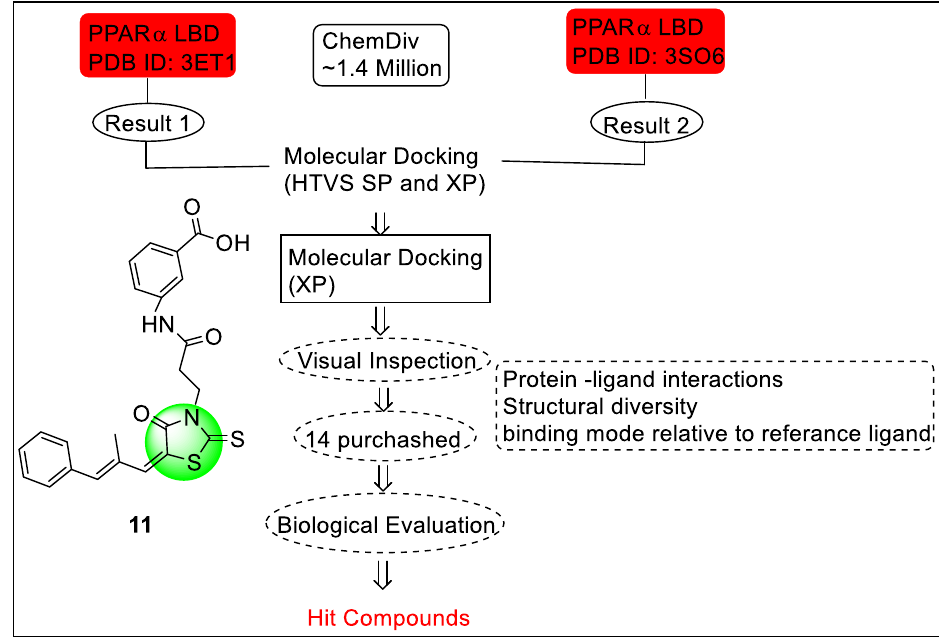
Figure 13. Workflow for the virtual screening of thiazolidinedione hybrids ( 11 ) as potent PPAR lig-